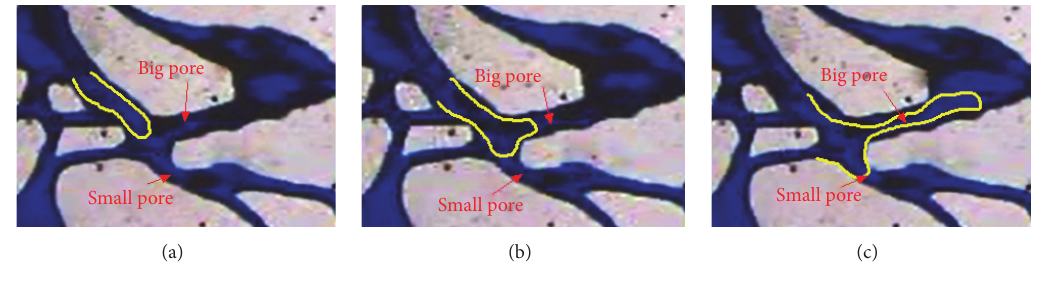
Figure 4: Weak gel flow